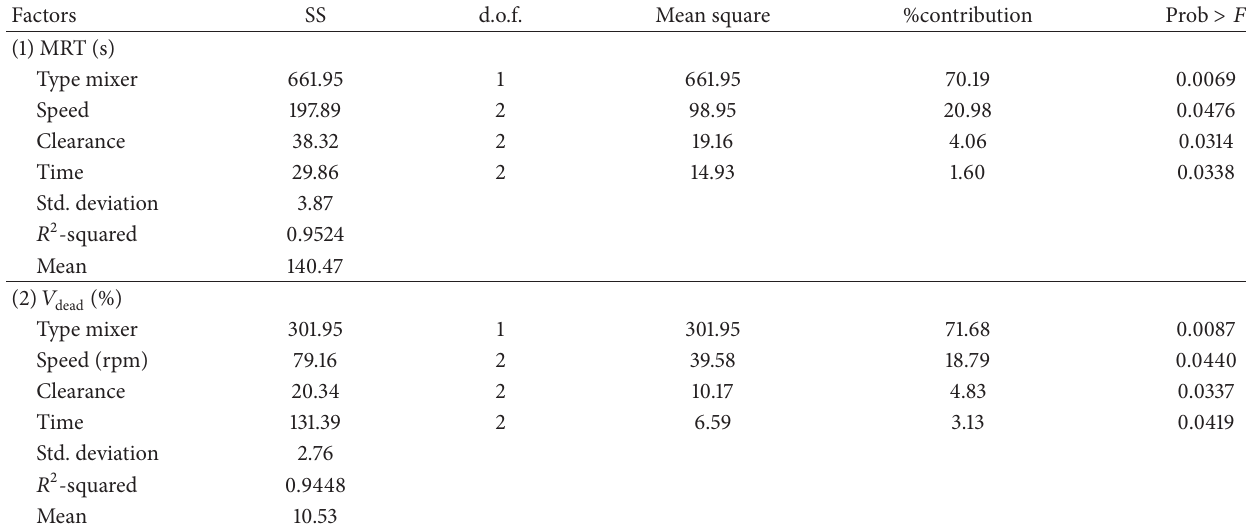
Table 5: ANOVA results for radiotracer experiments.